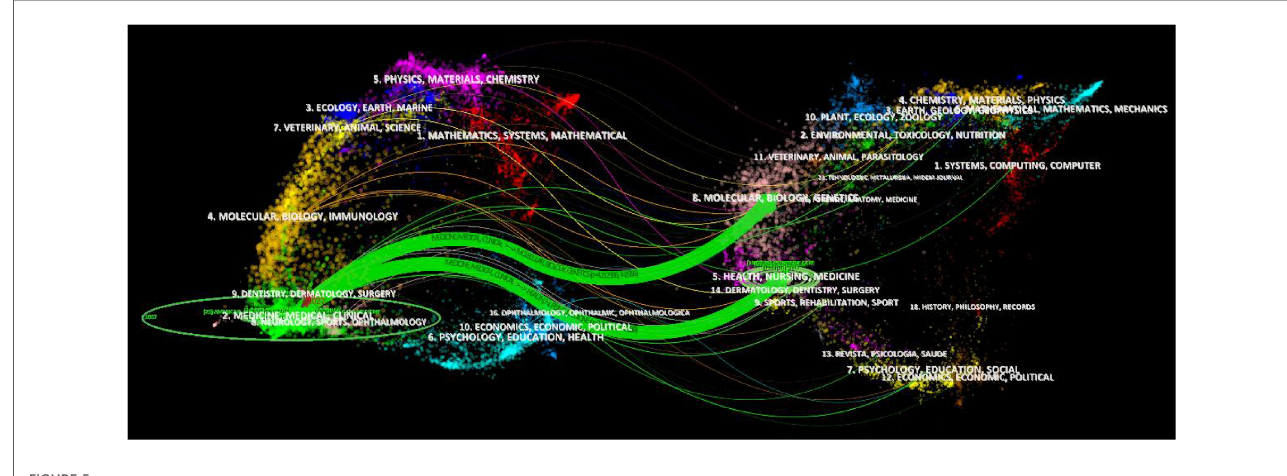
FIGURE 5 Dual-map overlay of journals related to pediatric bronchiectasis between 2003 and 2022. Citing journals are on the left, and cited journals are on the right. The horizontal axis of the ellipse represents the number of authors, and the vertical axis represents the number of publications. The lines depict the citation paths.